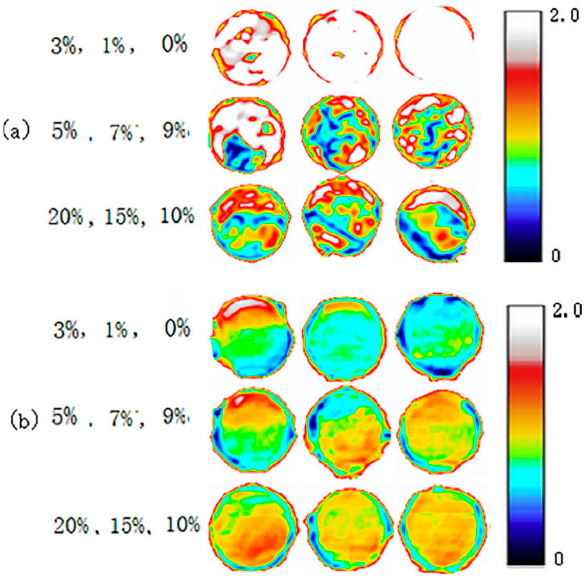
Figure 3. THz images of maltose mixtures: ( a ) the maltose and polyethylene mixtures; ( b ) the malt- ose and wheat starch mixtures